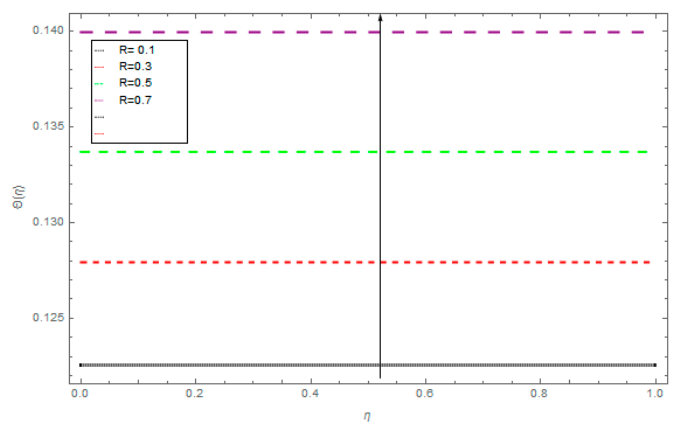
Coatings 2019 , 9 , x FOR PEER REVIEW Figure 11. The impact of the Prandtl number ( Pr ) on the Nusselt number. Figure 11. The impact of the Prandtl number ( Pr ) on the Nusselt number.